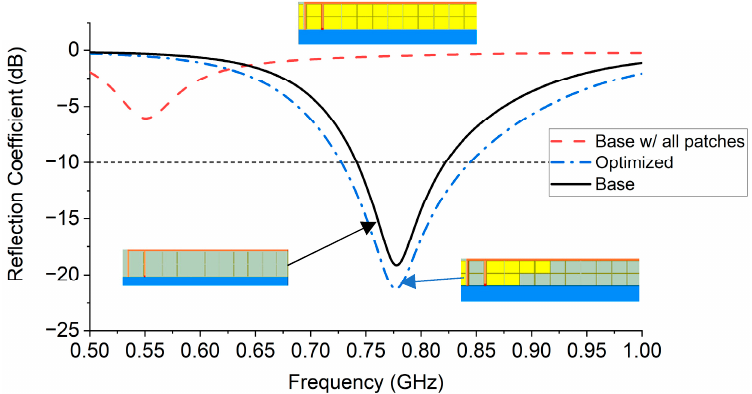
Figure 4. Simulated reflection coefficient of the base, base with all patches, and optimized IFAs.